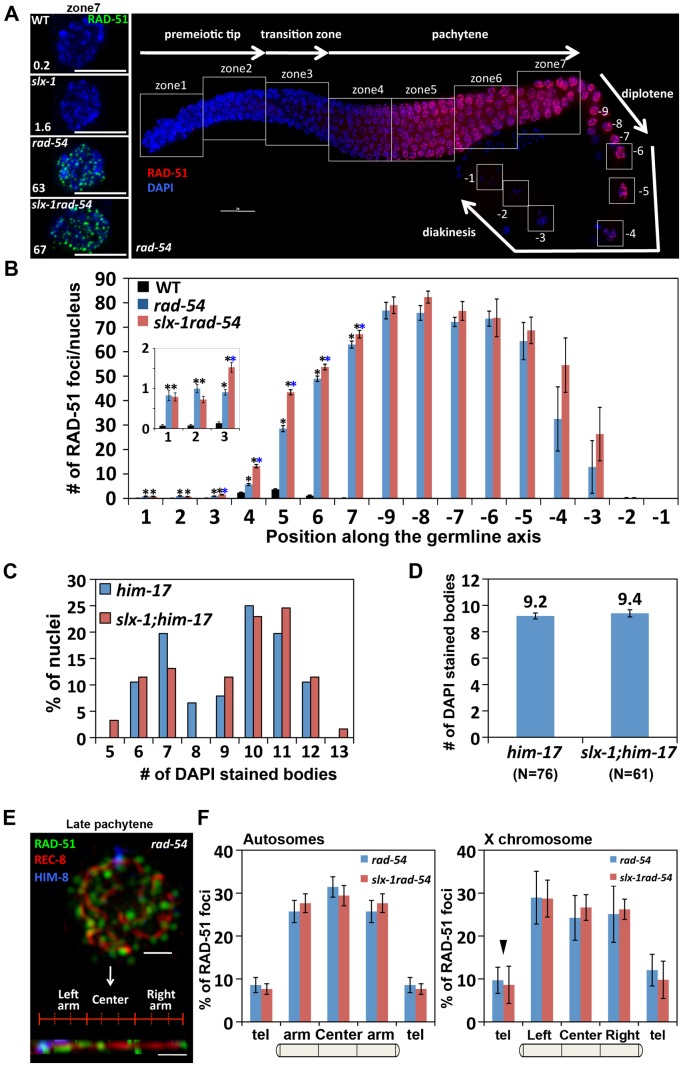
SLX-1 does not regulate either the levels or the distribution of DSBs.(A) Panels on the left are high magnification images of late pachytene nuclei (zone 7) immunostained with RAD-51 in the indicated genotypes. The average number of RAD-51 foci is shown at the bottom left. Bars, 5 µm. The panel on the right shows a typical immunostaining pattern for RAD-51 in whole mounted gonads of rad-54 mutants. The white squares indicate the seven zones and the diakinesis oocytes (−9 through −1) scored in the analysis. (B) Quantitation of the number of RAD-51 foci in wild type, rad-54 and slx-1rad-54 mutants. Error bars indicate standard error. Colored asterisks indicate statistical significance between different genotypes. (C) Quantitation of DAPI-stained bodies at late diakinesis (−1 and −2 oocytes) in six time outcrossed him-17(ok424) and slx-1;him-17(ok424) mutants. (D) Average number of DAPI-stained bodies in him-17(ok424) and slx-1;him-17(ok424) mutants. Bars indicate standard error. (E) A representative image of a late pachytene nucleus (zone 7) co-immunostained with RAD-51, REC-8 and HIM-8 antibodies and a computationally straightened chromosome axis (bottom) in rad-54 mutants. (F) Distribution of RAD-51 foci along chromosome axes in rad-54 and slx-1rad-54 mutants. RAD-51 foci localization on randomly selected autosomes are quantified in the left panel. The values of RAD-51 distribution on the left and the right arms are averaged as “arm” on the autosomes. The values at the left and the right telomeres are also averaged as “tel” on the autosomes. The distribution of RAD-51 foci on the X chromosome is shown in the panel at the right. Arrowhead indicates pairing center where HIM-8 localizes. Bars indicate standard error.